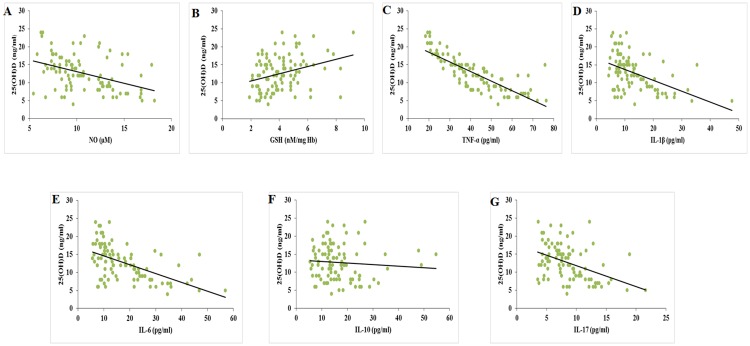
Correlation between 25 (OH) D and NO (Fig A), GSH (Fig B), TNF-α (Fig C), IL-1β (Fig D), IL-6 (Fig E), IL-10 (Fig F) and IL-17 (Fig G).